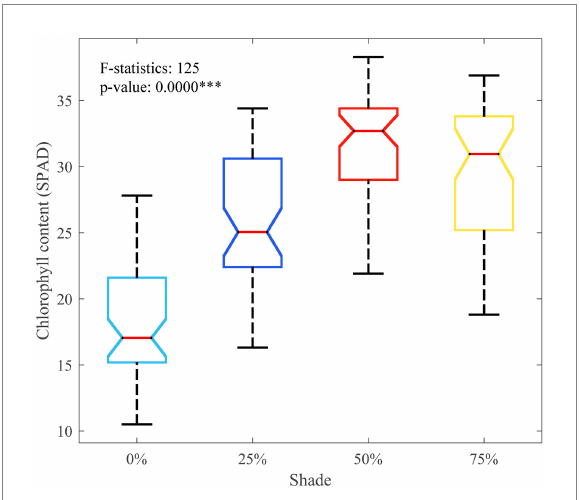
FIGURE 3 Chlorophyll content (SPAD) data distribution of seedlings under different shade levels. *** p < 0.001.